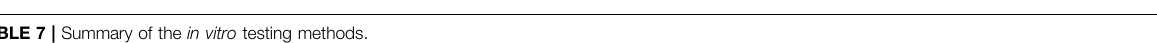
TABLE 7 | Summary of the in vitro testing